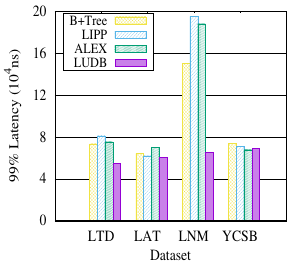
Figure 8. Latency.